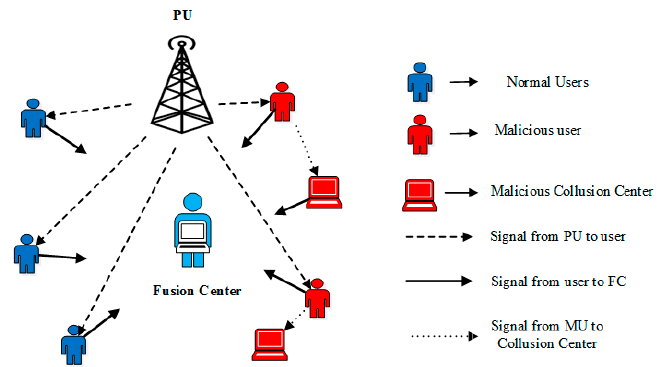
Figure 1. Conventional centralized cooperative spectrum sensing (CSS).